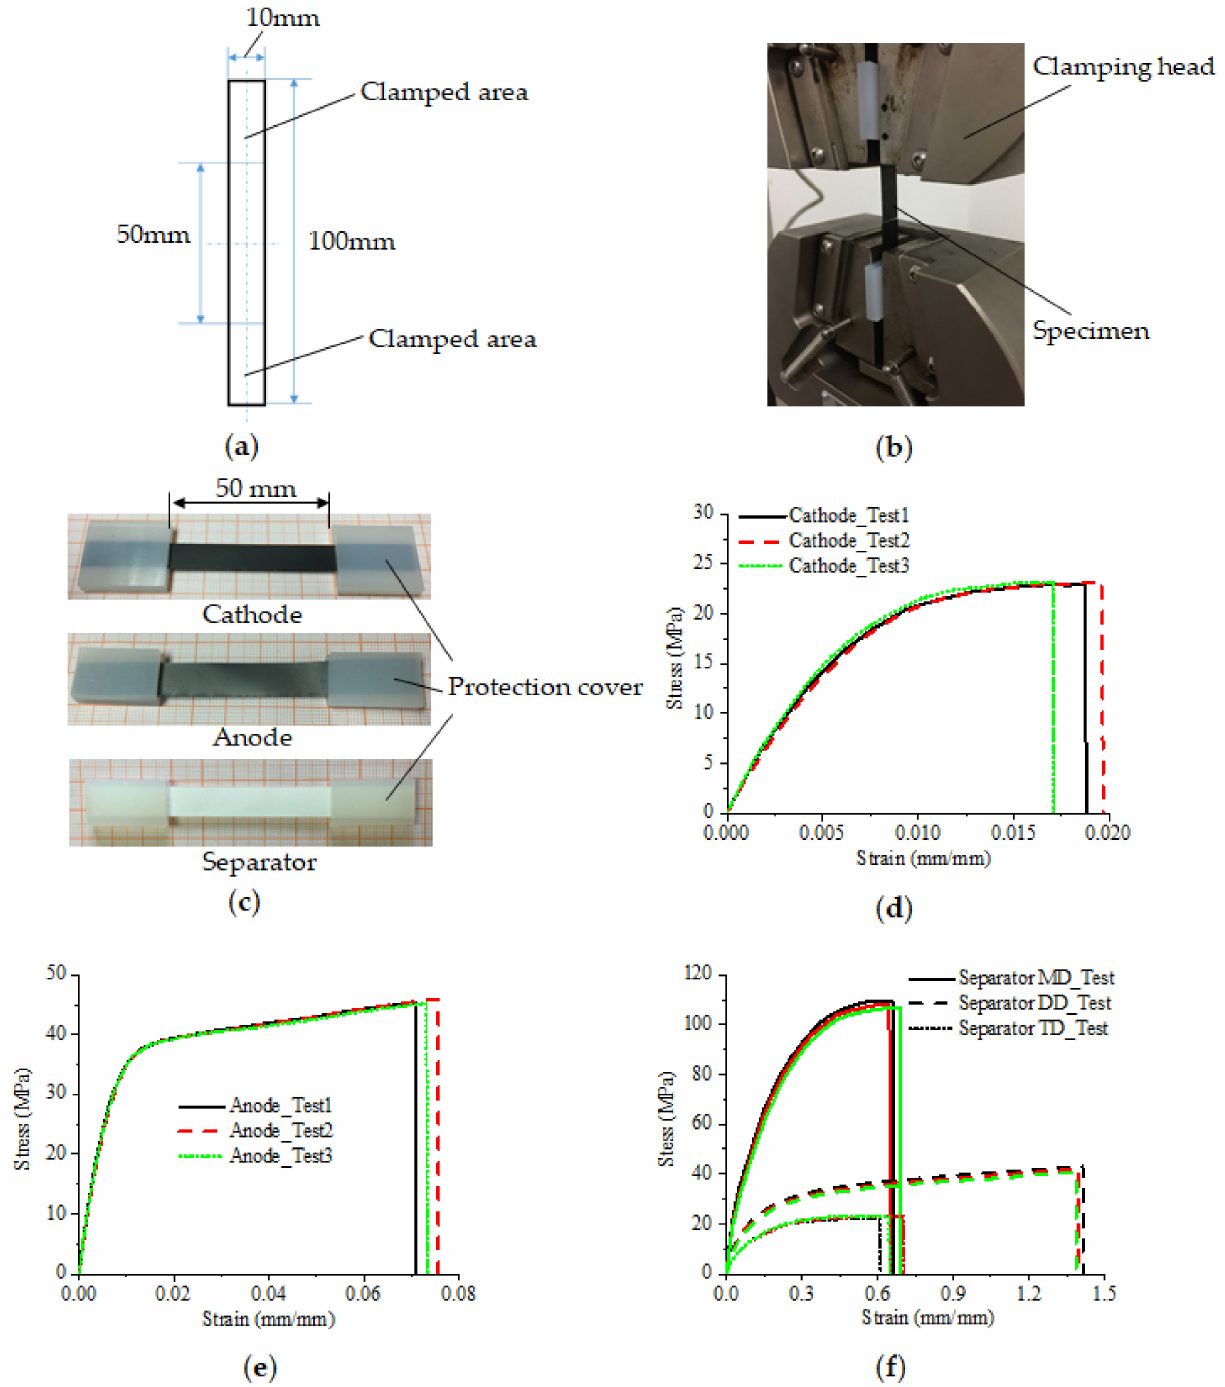
Figure 2. Tensile test of component materials of prismatic cell: ( a ) Specimen size; ( b ) Test setup; ( c ) Specimens of tested component materials; ( d ) Tesile stress-strain curves for cathode specimen; ( e ) Tesile stress-strain curves for anode specimen; ( f ) Tesile stress-strain curves for separator